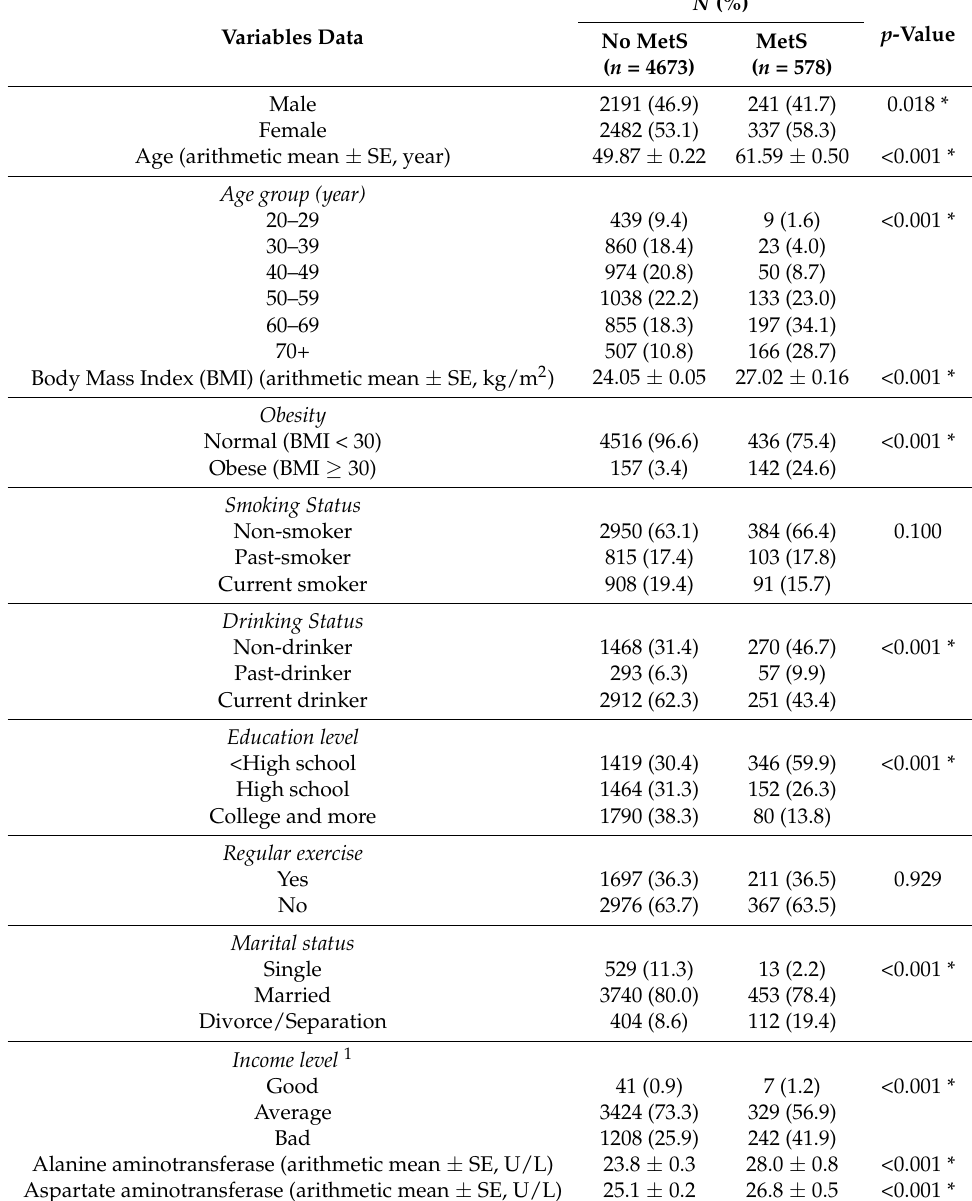
Table 1. Demographic and clinical characteristics of the study subjects by metabolic syndrome